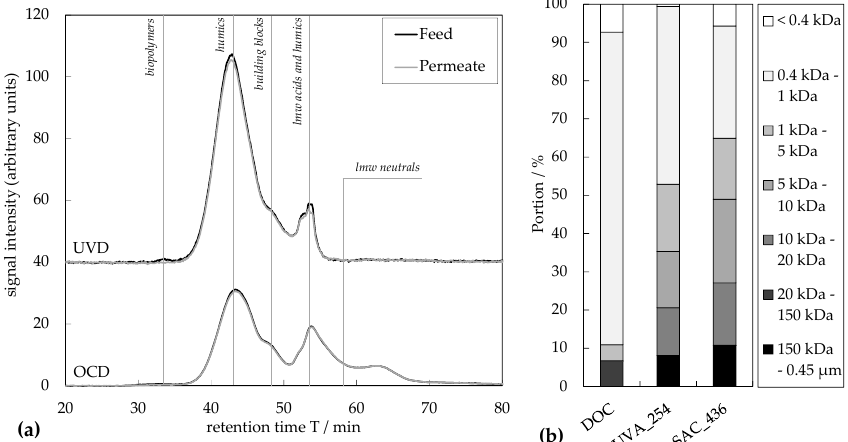
Figure 1. ( a ) LC-OCD-UVD chromatogram of feed water and permeate after filtration by a 150-kDa UF membrane without addition of PAC containing typical DOC fractions according to Huber et al. (2011) [37]; ( b ) Size distribution of organic bulk parameters (DOC, UVA 254 and SAC 436 ) of the feed water determined by fractionation by applying membranes with different MWCOs.